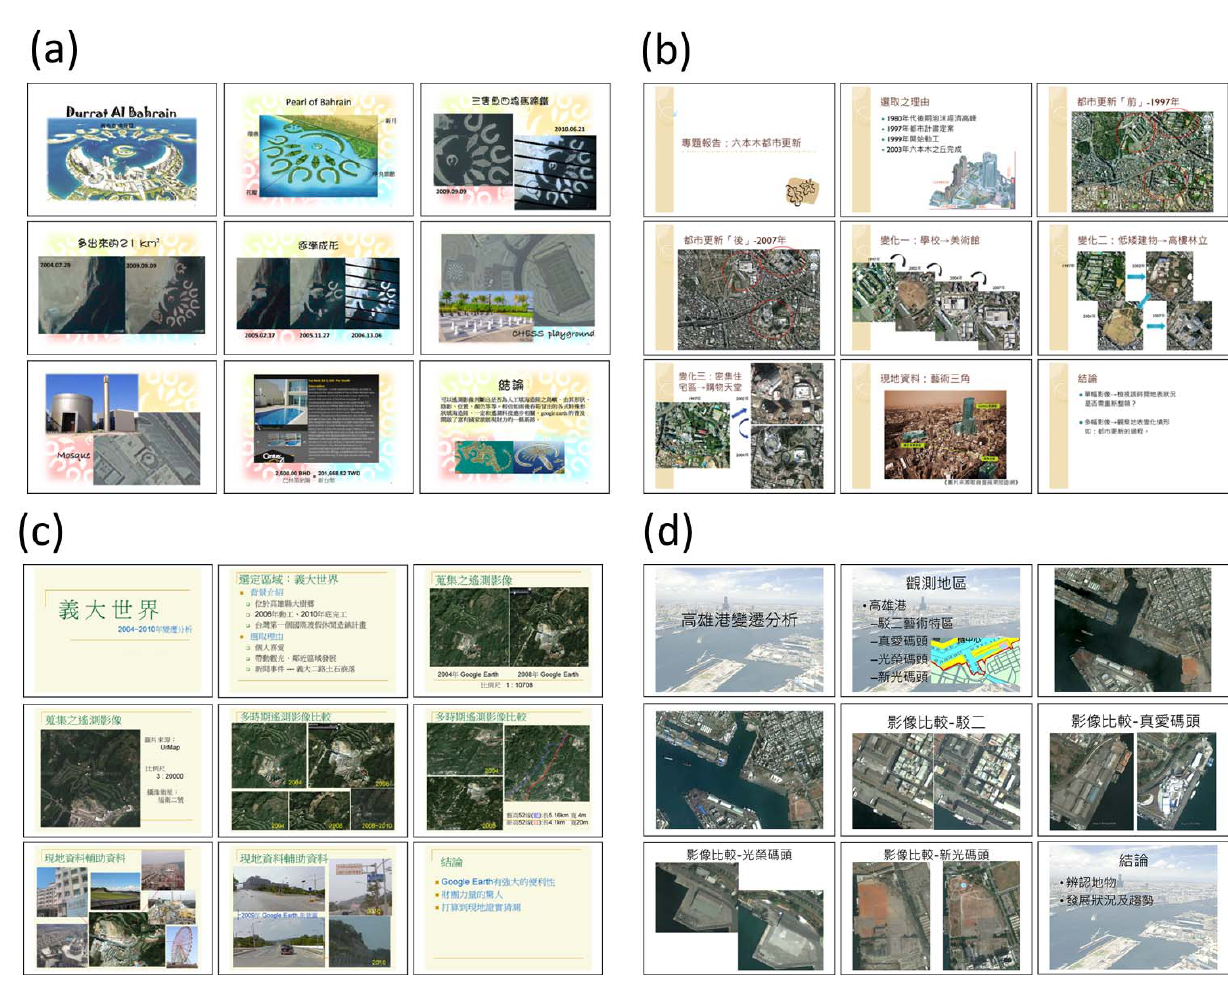
Figure 2 Example final presentations from the 2010 Fall class with the AOI at (a) Durrat Al Bahrain, Kingdom of Bahrain, (b) Roppongi, Tokyo, Japan, (c) A resort at Kaohsiung, Taiwan, and (d) Port of Kaohsiung,